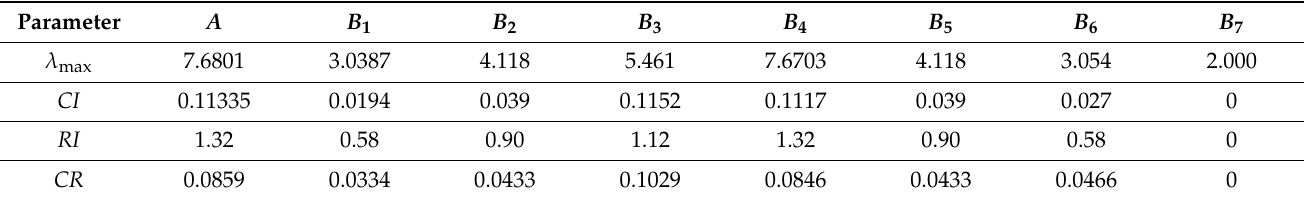
Table 3. Consistency test results of evaluation indicators of safety culture construction level in colleges and